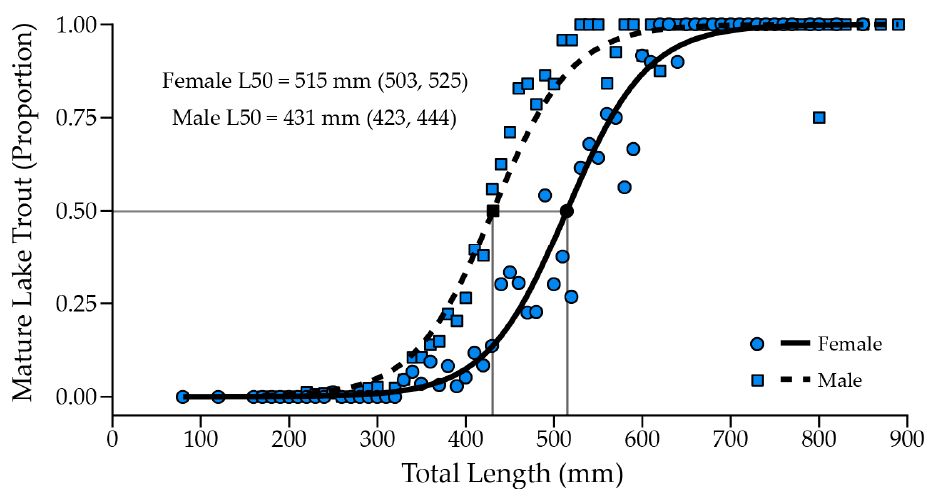
Figure A6. Proportions of mature female (n = 1766) and male (n = 2812) lake trout captured in Yellowstone Lake from 1996–2019 in 10-mm length bins with estimated length at which 50% of fish were mature (L50; black symbols at inflection points) and 95% confidence limits (in parentheses).